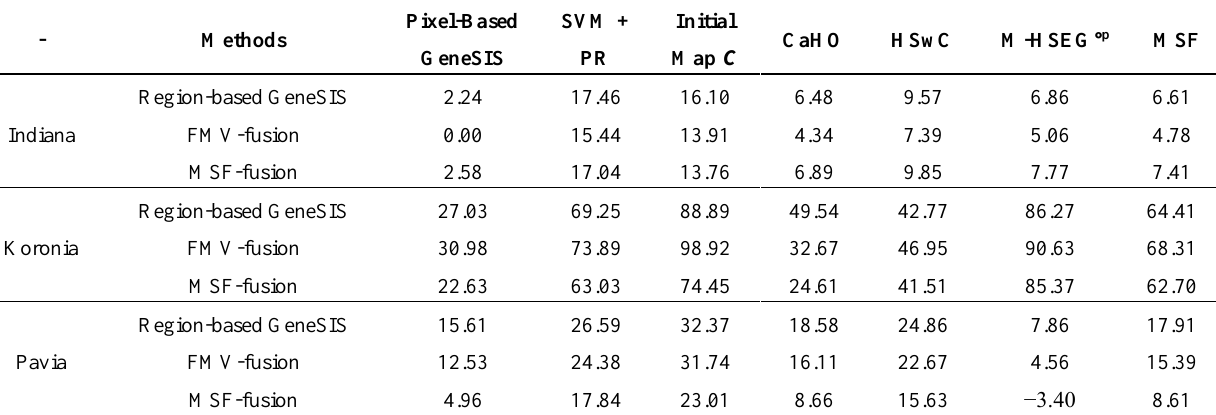
Table 8. Summary of pair-wise classification comparisons using the McNemar test. Our region-based GeneSIS and the two fusion schemes (rows) are compared to the pixel-based GeneSIS and six other methods (columns). One-sided tests are performed with 5% level of